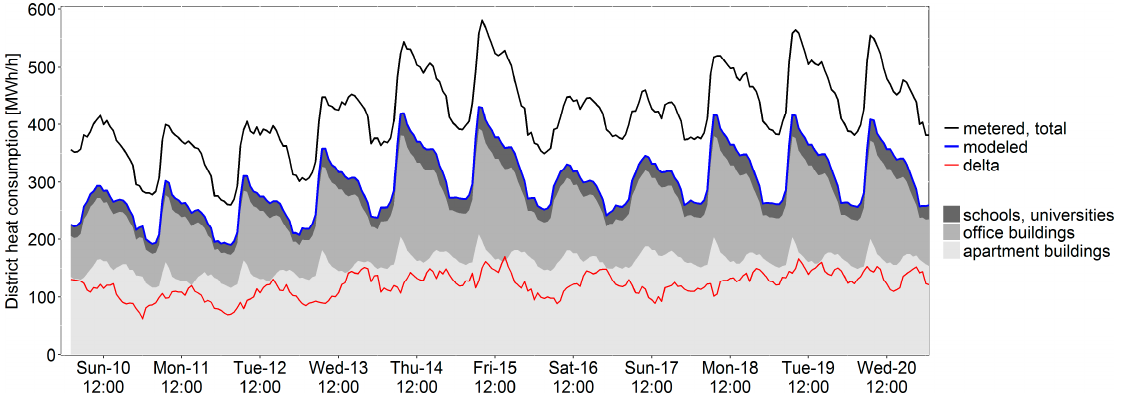
Figure 10. Modeled and metered [48] district heat consumption, and residual consumption delta, January 2016.